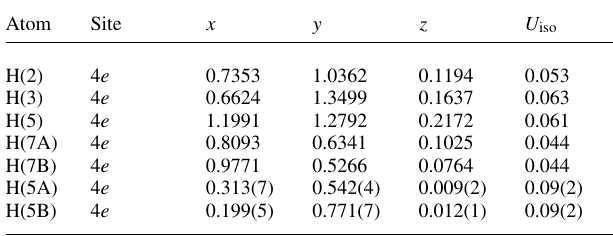
Table 2. Atomic coordinates and displacement parameters (in Å 2 )